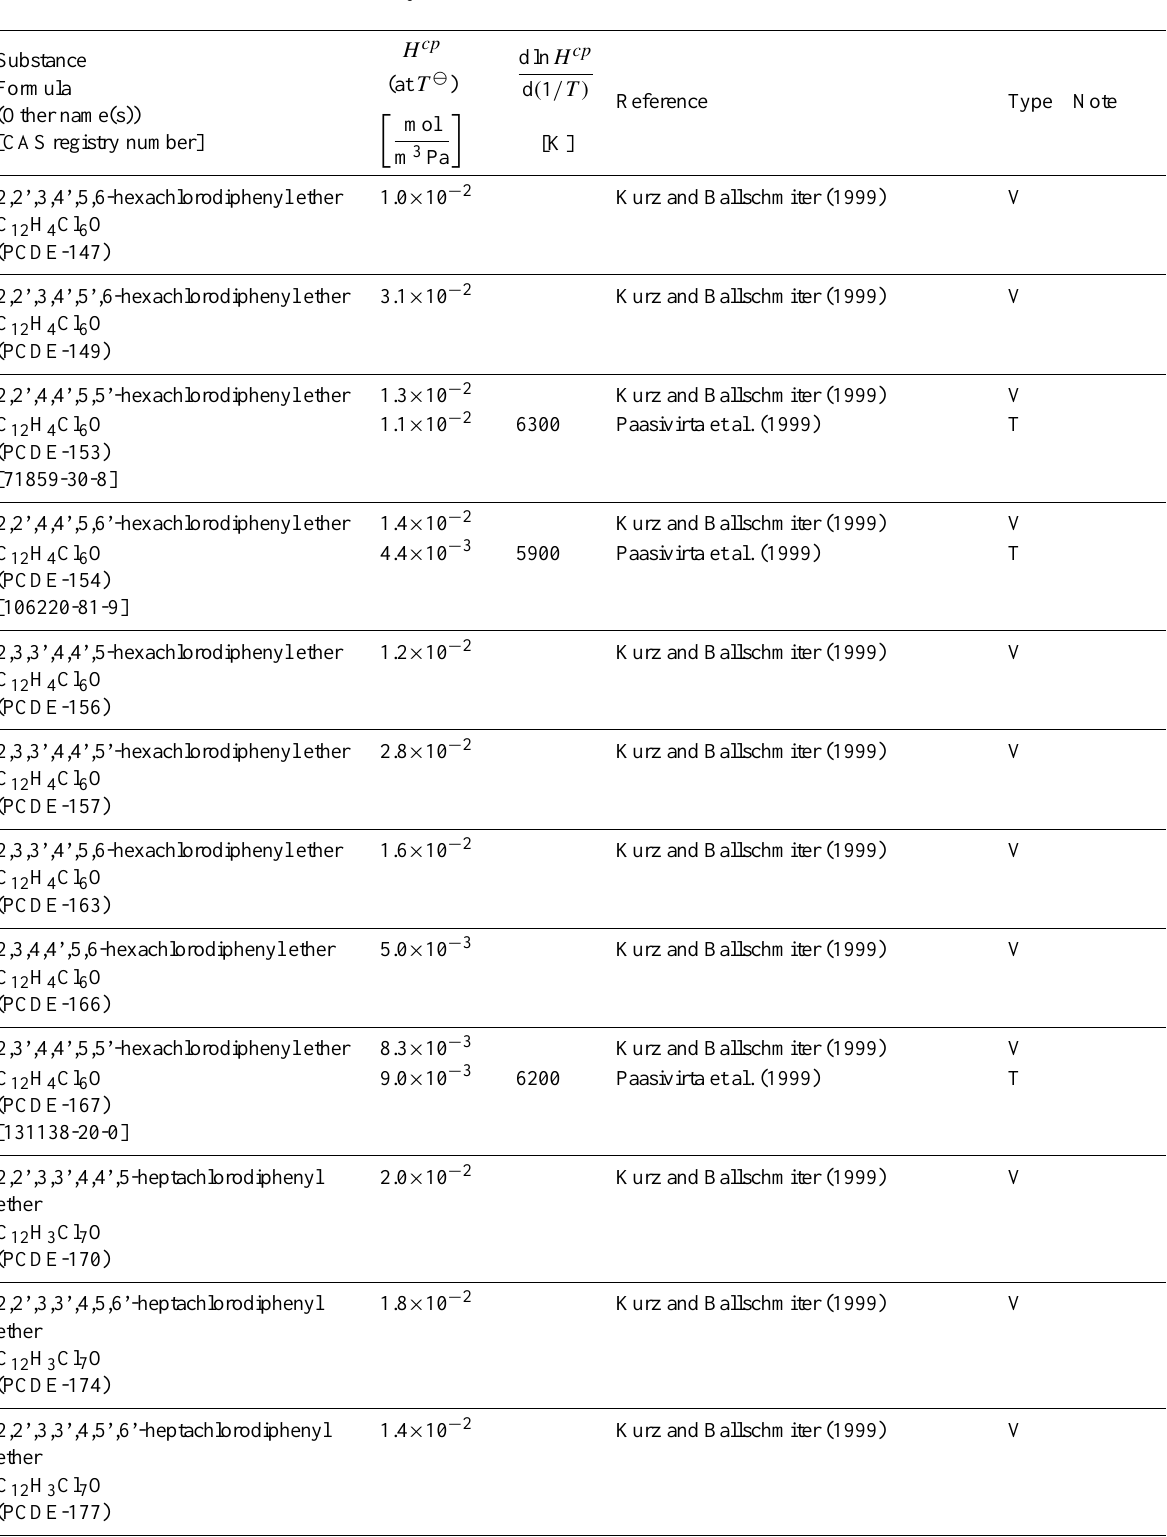
Table 6: Henry’s law constants for water as solvent